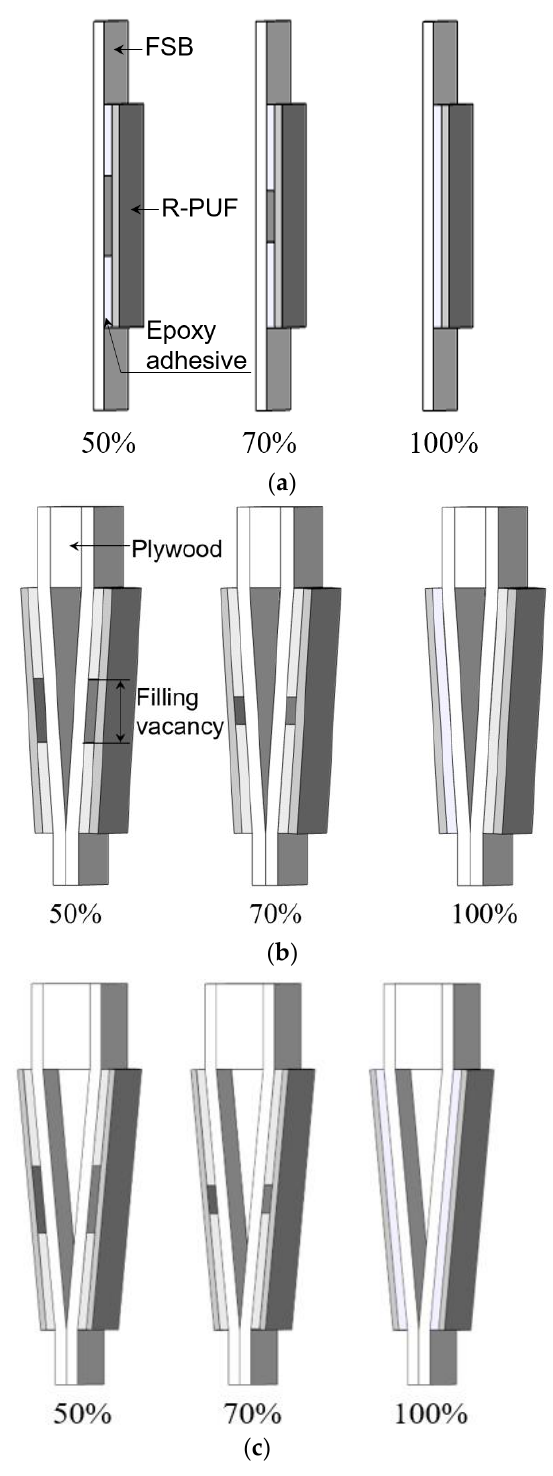
Figure 7. Schematic diagram of specimens with different level differences/adhesive filling ratios: ( a ) 0 mm/50%, ( b ) 3 mm/70%, and ( c ) 6 mm/100%.